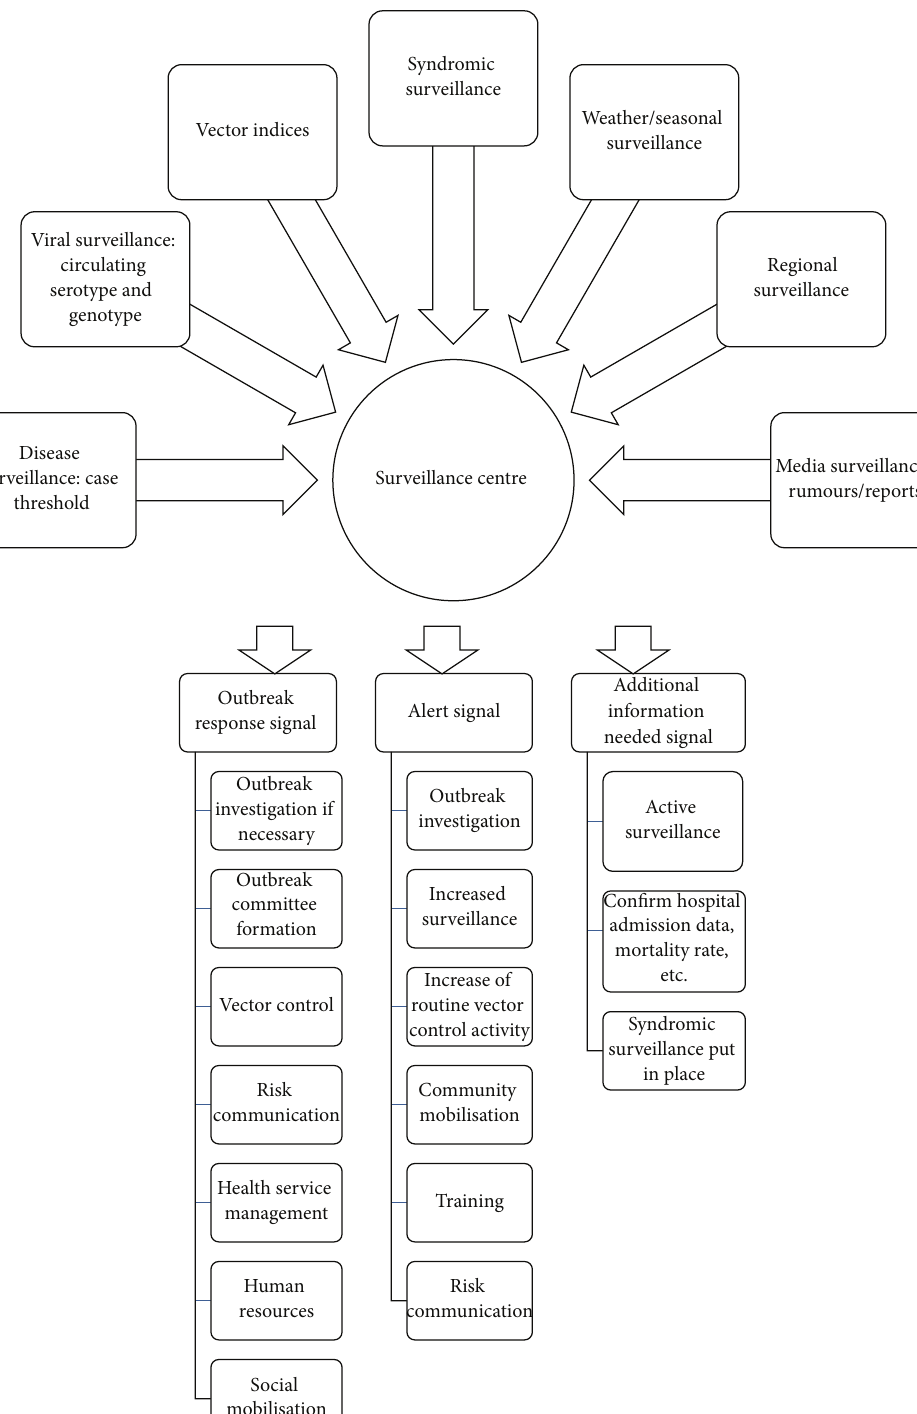
Figure 1: Alert signals of a dengue outbreak and possible